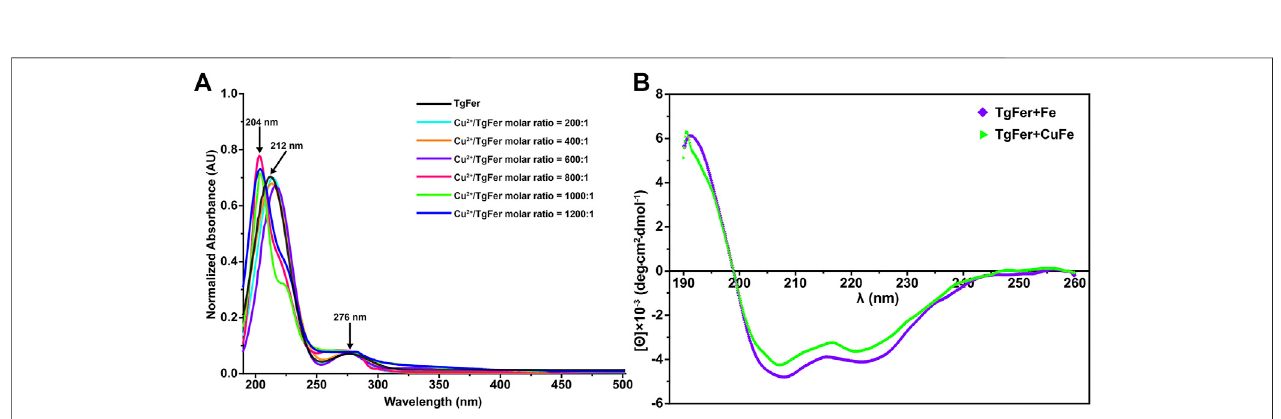
FIGURE 8 | (A) UV – vis absorption spectra of TgFer samples treated with Cu 2+ ions. Cu 2+ /TgFer molar ratios ranging from 200:1 to 1,200:1. The peaks corresponding to ferritins are indicated by a black arrow. (B) Circular dichroism spectra of TgFer + Fe and TgFer +